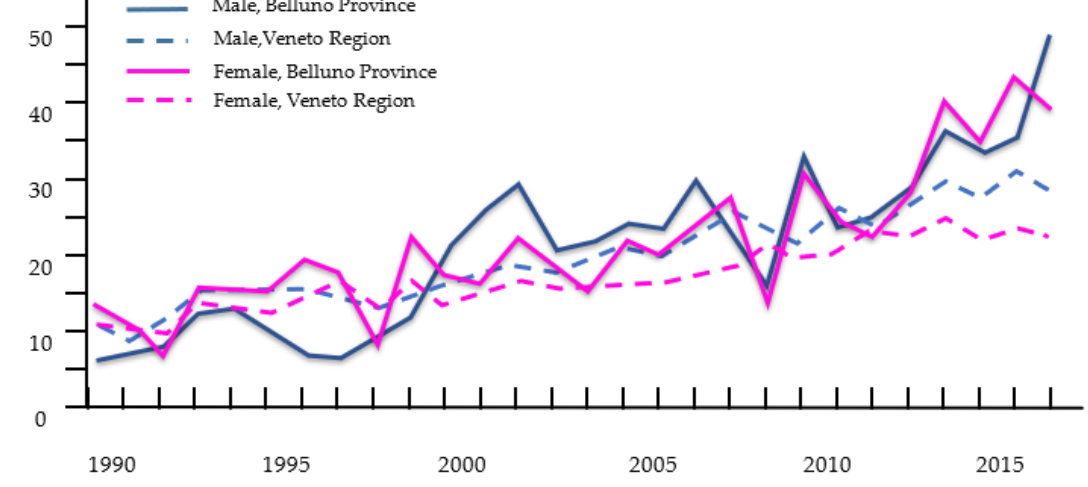
Figure 1. Years 1990–2017. Temporal trend of CMM incidence rate by sex. Comparison between Veneto regional (Veneto) and Alpen Belluno province populations.